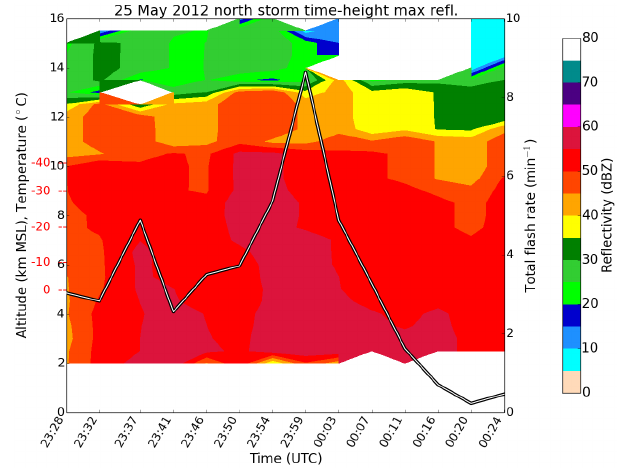
Figure 13. As in Fig. 6, but for the 25–26 May 2012 northern (weaker)